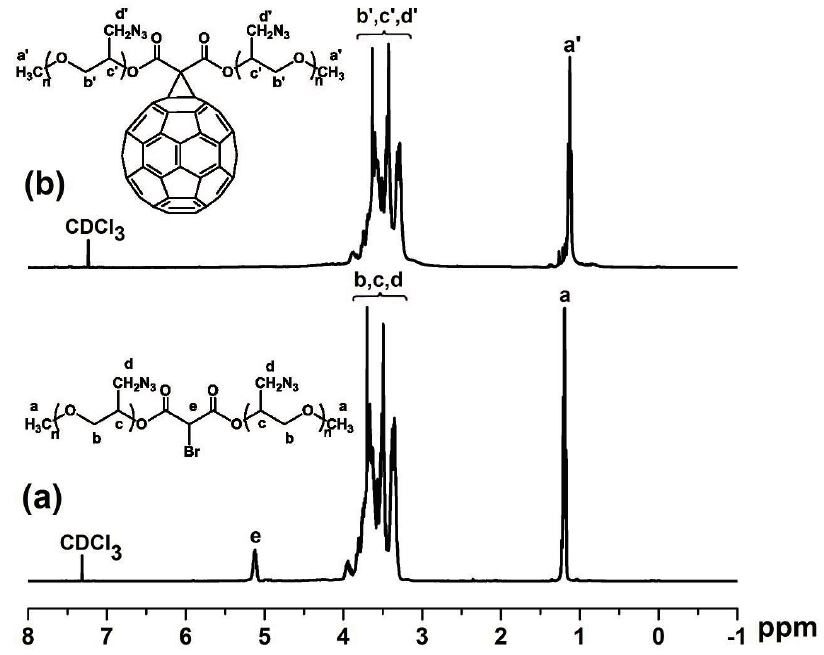
Figure 3. 1 H NMR spectra of ( a ) BM-GAP and ( b ) C 60